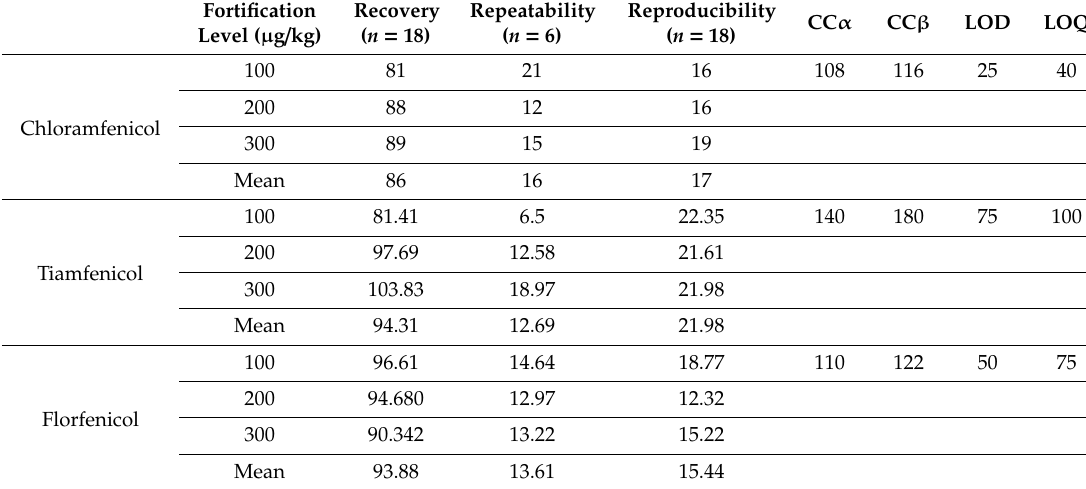
Table 2. Recovery (%), repeatability (CV%), reproducibility (CV%), CC α ( µ g / kg), CC β ( µ g / kg), LOD ( µ g / kg) and LOQ ( µ g / kg) of Chloramfenicol, Tiamfenicol and